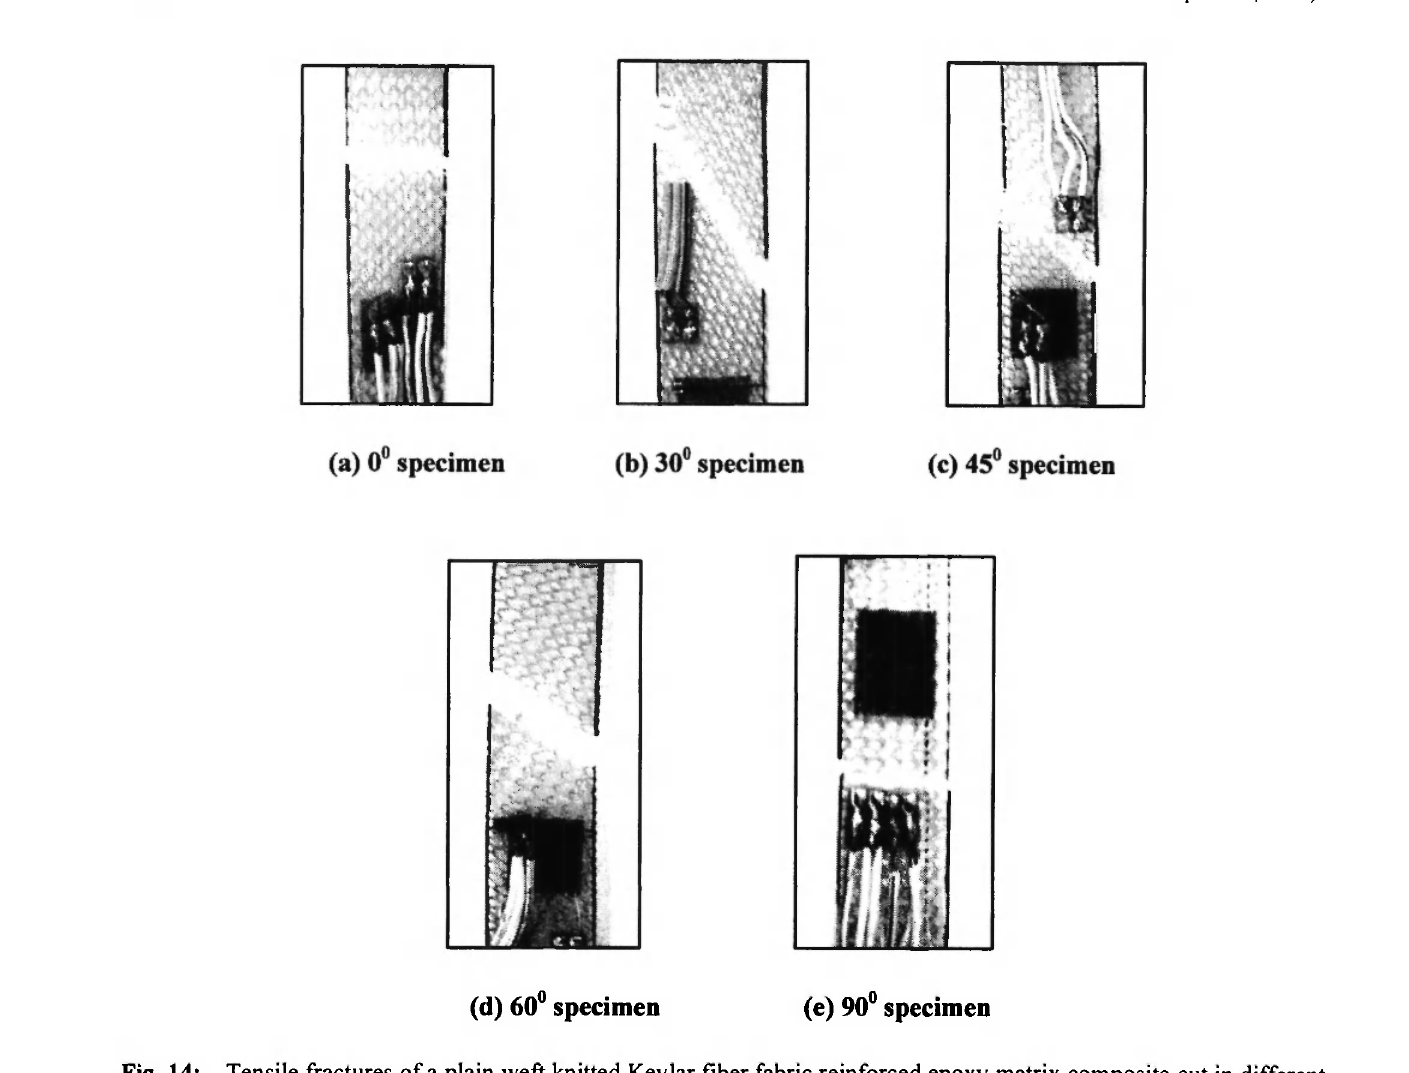
Tensile fractures of a plain weft knitted Kevlar fiber fabric reinforced epoxy matrix composite cut in different off-axial directions subjected to a uniaxial